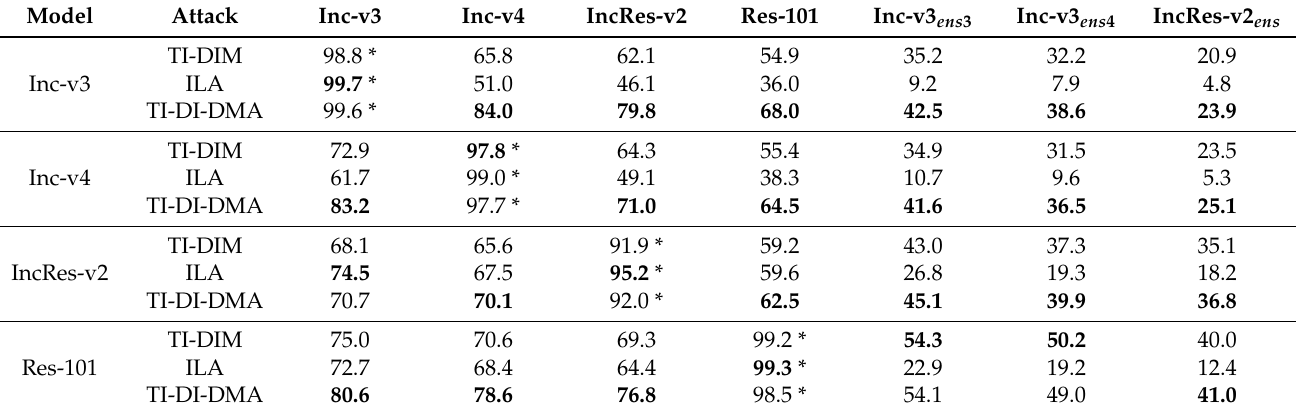
Table 2. The success rates of TI-DIM, ILA, and TI-DI-DMA. The proxy of ILA is crafted by TI- DIM. The adversarial examples are crafted for Inc-v3, Inc-v4, IncRes-v2, and Res-101, respectively. * indicates the white-box attacks.